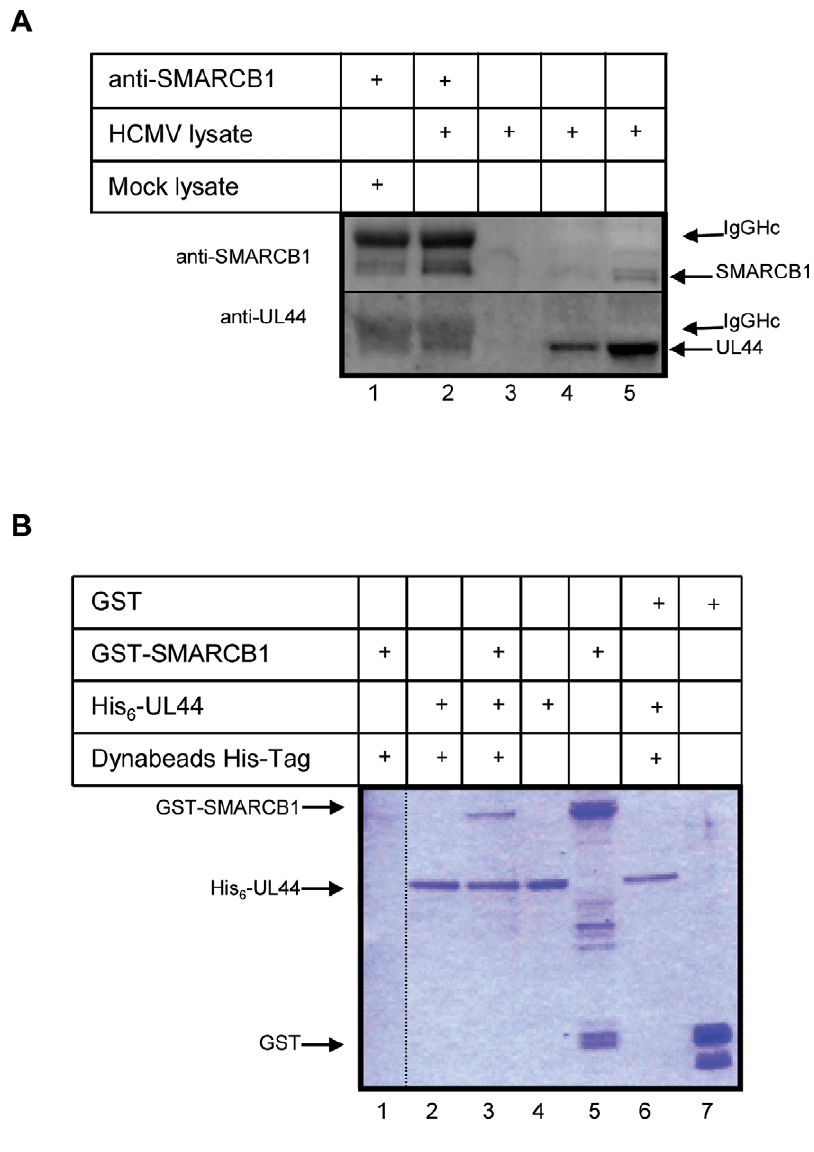
Figure 5. Interaction of SMARCB1 and UL44 in HCMV-infected fibroblast cells and with recombinant proteins. ( A ) Co- immunoprecipitation of endogenous SMARCB1 and UL44 in HCMV-infected fibroblast cells. Equal numbers of mock infected and HCMV infected fibroblast cells were lysed at 72 hpi, and the extracts were immunoprecipitated with anti-SMARCB1. Co-immunoprecipitated proteins were resolved electrophoretically and subjected to immunoblot analysis with anti-UL44 and anti-SMARCB1. Lane 1: Mock lysate immunoprecipitated with anti- SMARCB1. Lane 2: HCMV lysate immunoprecipitated with anti-SMARCB1. Lane 3: HCMV lysate immunoprecipitated with no antibody. Lanes 4 and 5, SMARCB1 and UL44 input in extracts (7 m g, 1% of the total in Lane 4 and 35 m g, 5% of the total in Lane 5). IgGHc: IgG heavy chain. ( B ) In vitro pull- down assay of GST-SMARCB1 and His 6 -UL44. Purified GST-SMARCB1 or GST incubated with purified His 6 -UL44 immobilized on magnetic His-tag Dynabeads. Samples were analyzed by SDS-PAGE and Coomassie blue staining. Lane 1: GST-SMARCB1 + Dynabeads His-tag. Lane 2: His 6 - UL44 + Dynabeads His-tag. Lane 3: GST-SMARCB1 + His 6 -UL44 + Dynabeads His-tag. Lane 4: His 6 -UL44 (2 m g, 10% of input). Lane 5: GST-SMARCB1 (2 m g, 10% of input). Lane 6: GST + His 6 -UL44 + Dynabeads His-tag. Lane 7: GST (2 m g, 10% of input). Note that spontaneous cleavage of GST occurred in the GST-SMARCB1 protein sample (Lane 5). ( …… ) indicates that samples were run on the same gel.